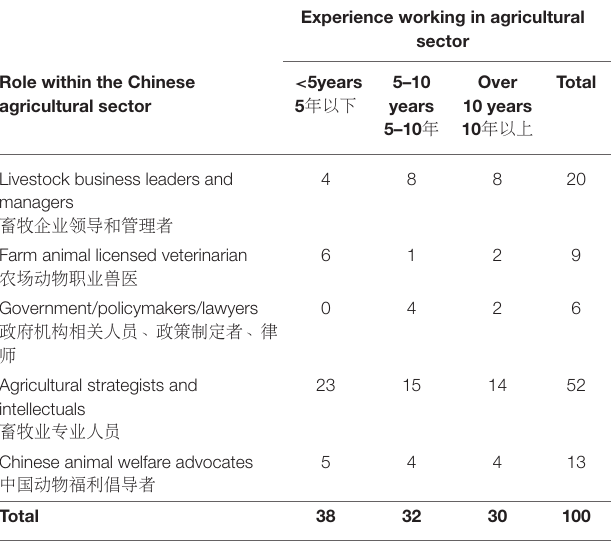
TABLE 2 | Research participants ( n = 100) by role and years of